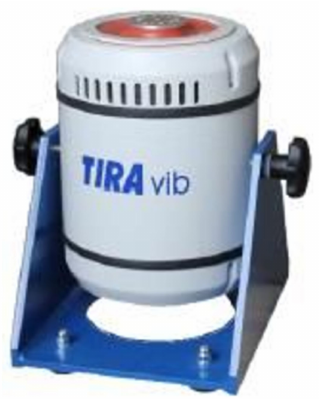
Figure 2. Modal exciter of German